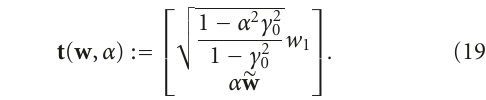
Algorithm 3 exploits the ring structure of a